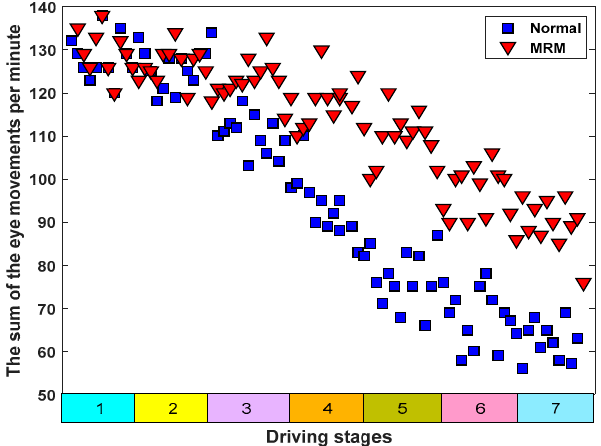
Figure 12. The sum of the eye movements of each driver in the experiments.